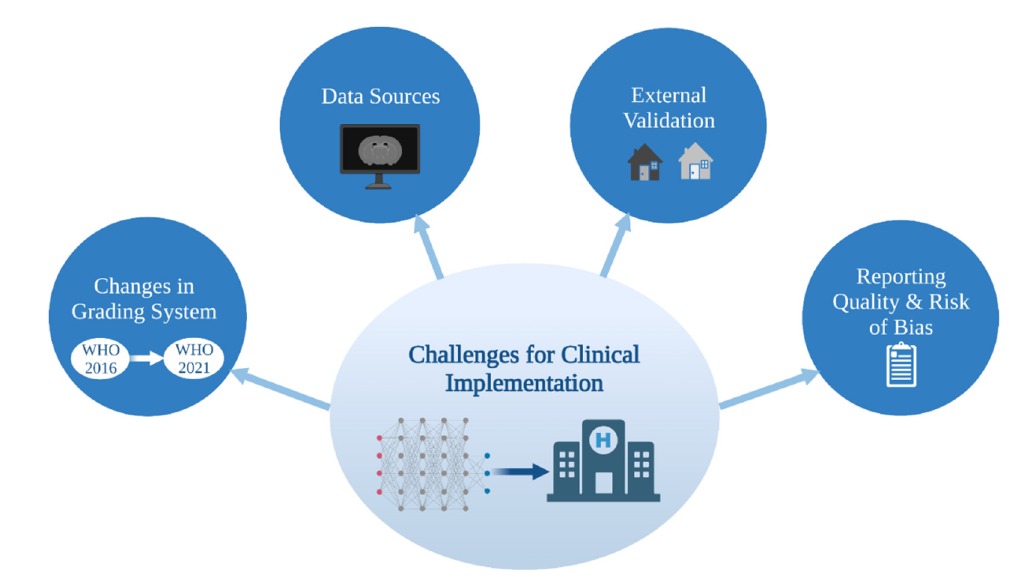
Figure 2. Challenges for clinical implementation of ML glioma grade prediction models. ML = machine learning. WHO = World Health Organization.